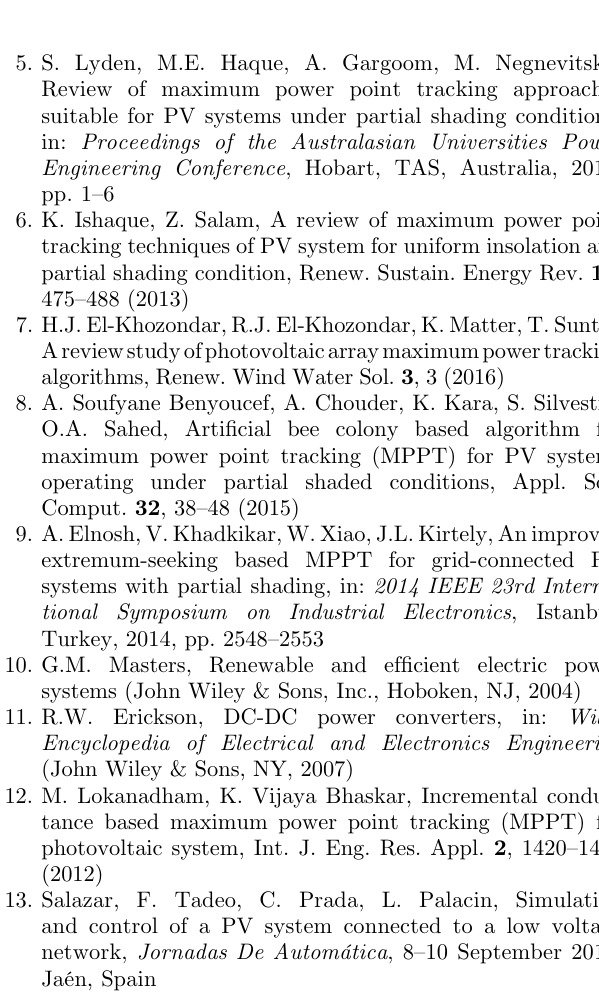
Fig. 15. Power curve for fi xed temperature and variable